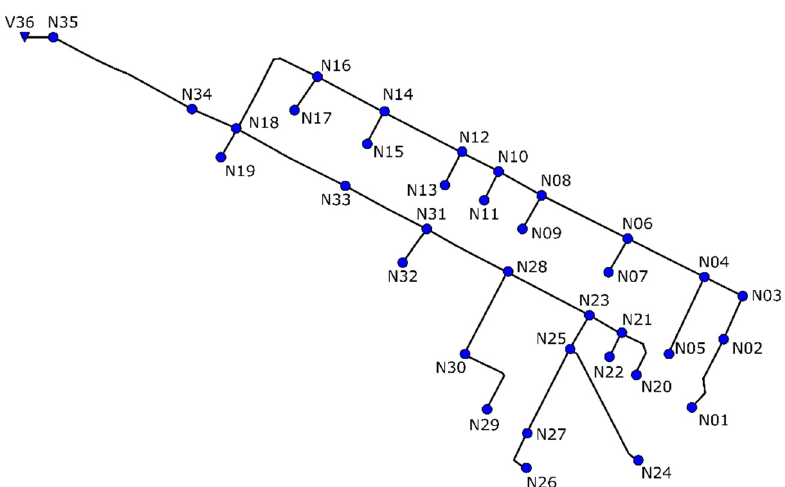
Figure 3. Representation of E-Chicó drainage network.